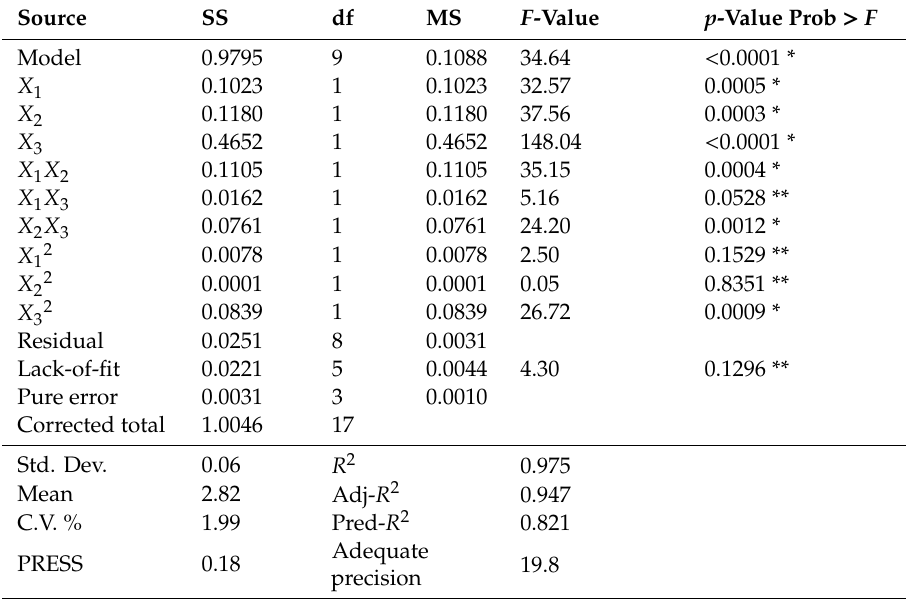
Table 4. Analysis of variance (ANOVA) of the quadratic response surface model.